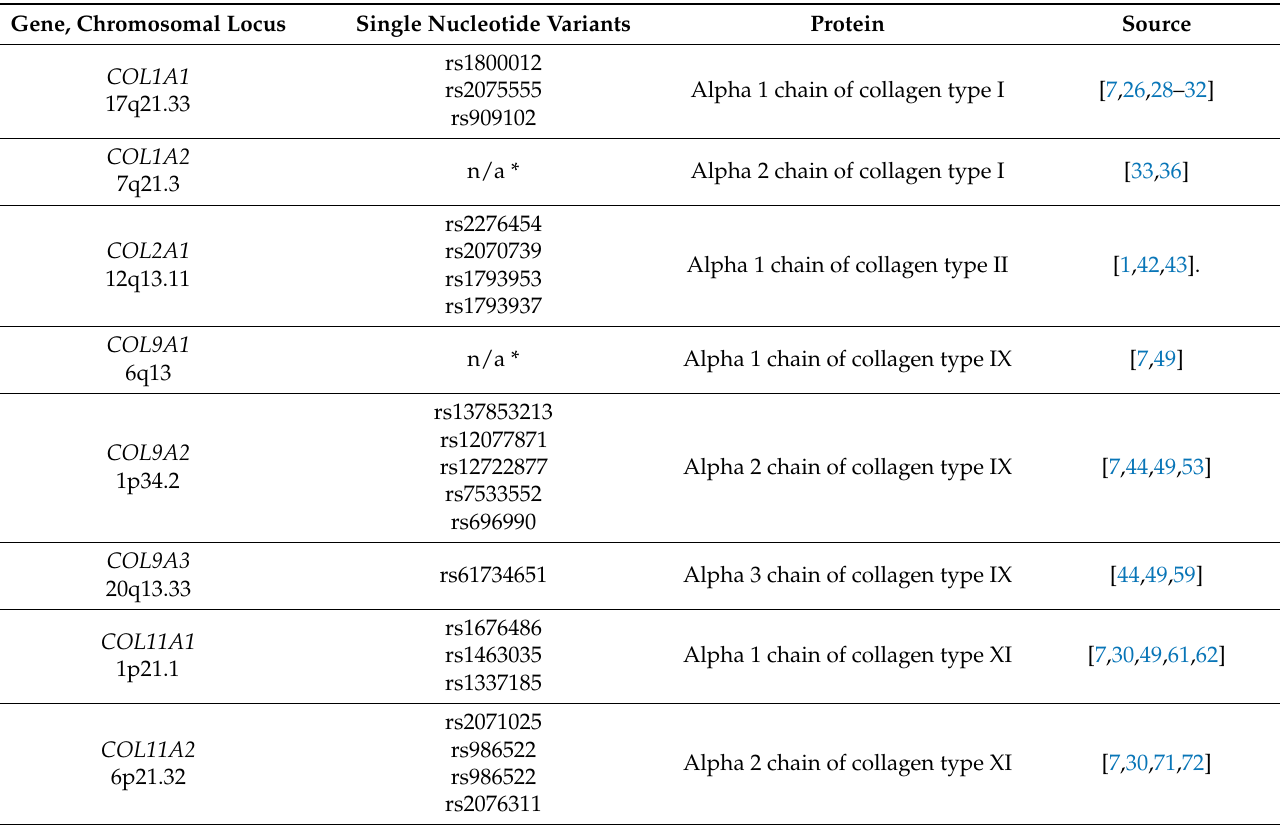
Table 2. Candidate genes encoding collagens and their single nucleotide variants associated with degeneration of interver- tebral discs in humans. Gene, Chromosomal